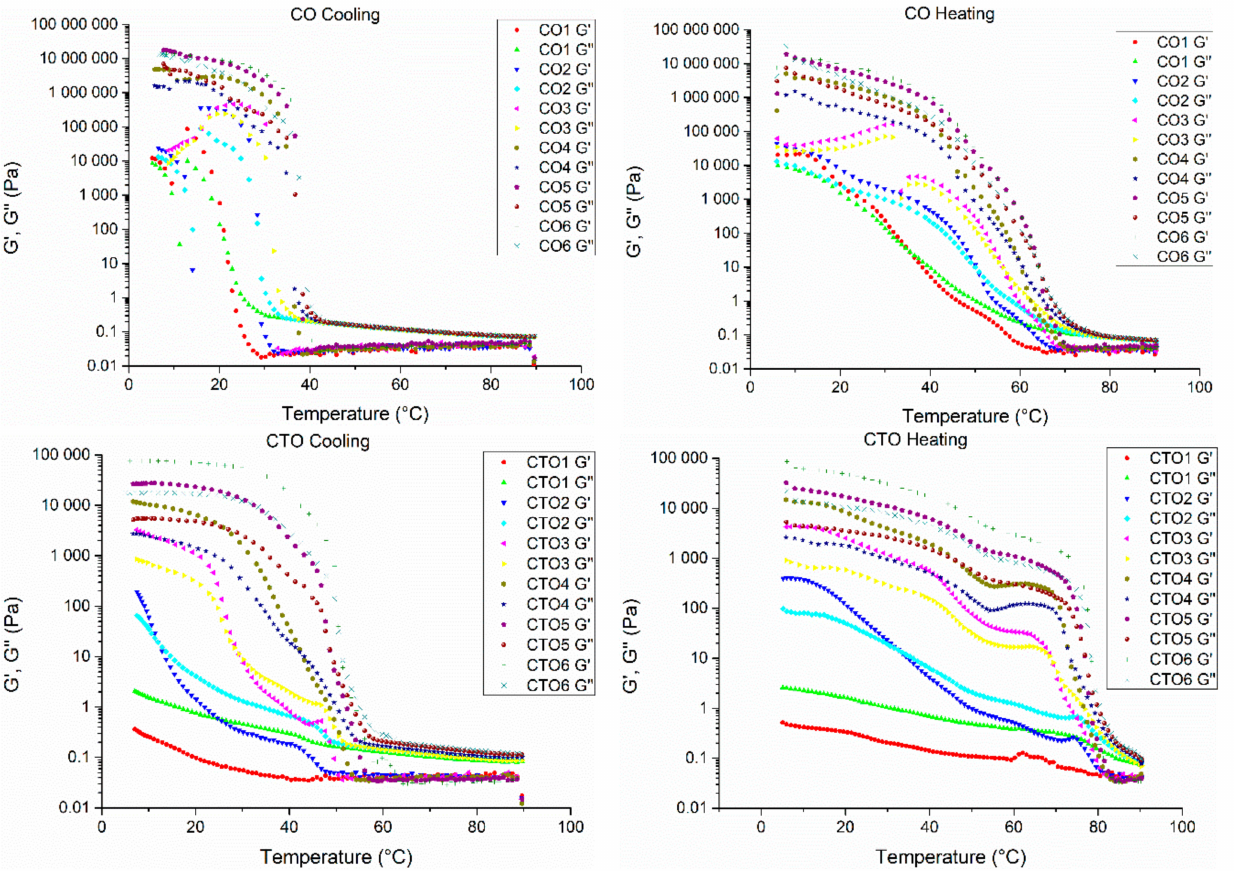
Figure 6. Temperature sweeps, heating and cooling stages are shown for all organogel samples. G’ —Storage Modulus, G” —Loss